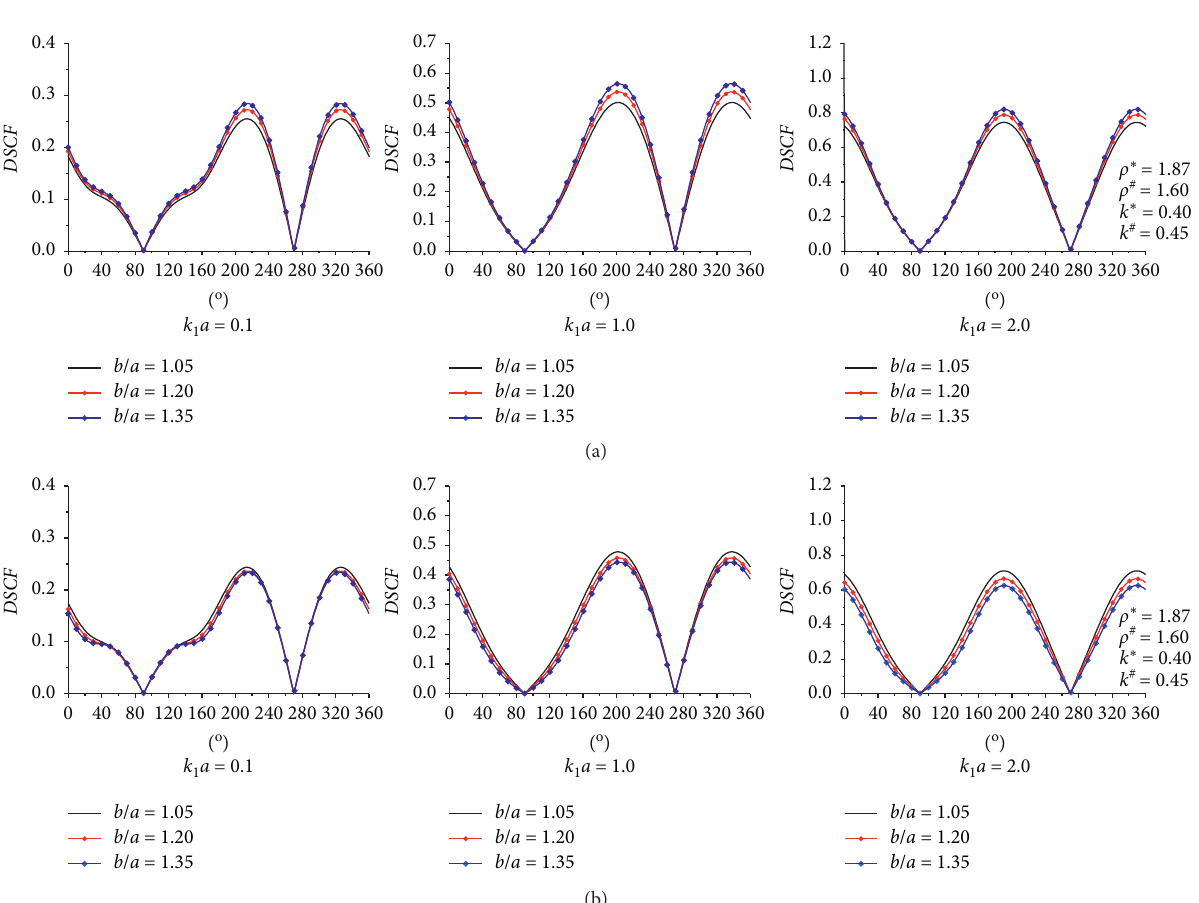
Figure 9: Variation of DSCF Condition A-Q345: inner surface.